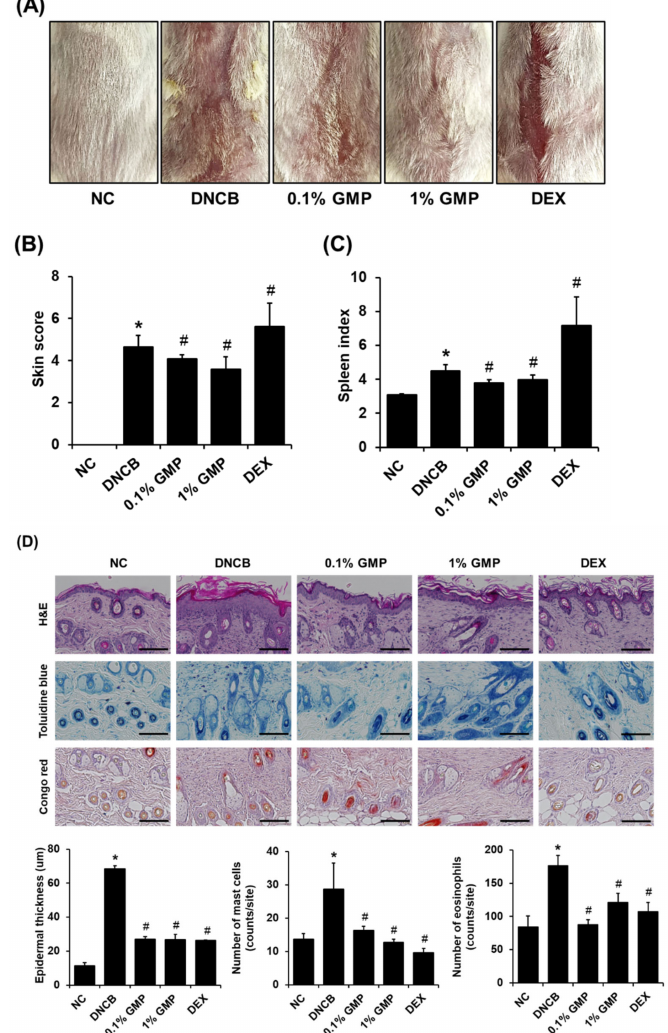
Figure 2. Effect of GMP on AD-like symptoms in DNCB-treated BALB/c mice. ( A ) Images of dorsal skin lesions from each group were taken at the end of the experiment. ( B ) The total skin score of dorsal skin lesions ( C ) Spleen index was measured. ( D ) Histological and immunohistochemical staining of dorsal skin samples. Scale bar: 100 µ m. Data represent the means ± SDs. * p < 0.05 compared to the NC group, # p < 0.05 compared to the DNCB group. AD, atopic dermatitis; GMP, Gomokpi; DEX, dexamethasone; DNCB,